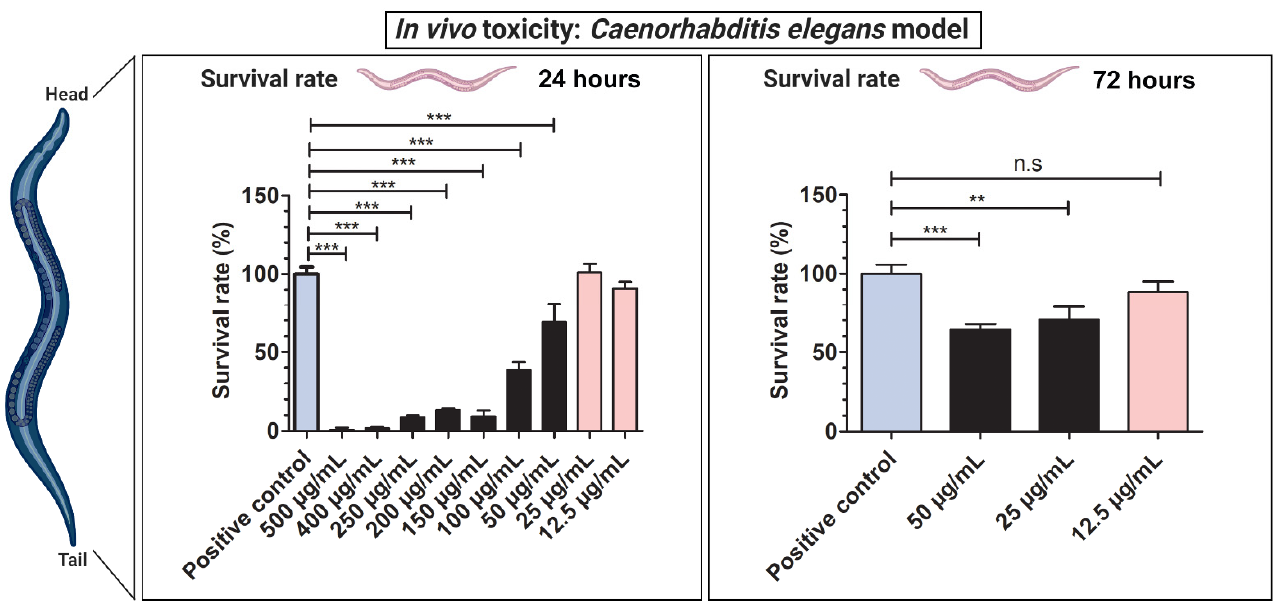
Figure 7. Survival rate of the Caenorhabditis elegans in vivo toxicity model after 24 h (acute toxicity) and 72 h (chronic toxicity) of exposure to graphene nanoplatelets (GNPs). Data are expressed as the mean ± standard deviation of five replicates (n = 5). The results of the statistical analysis with respect to positive control and to the epidermal growth factor (EGF) are indicated in the graph: ** p < 0.01; *** p < 0.001, n.s: not significant.